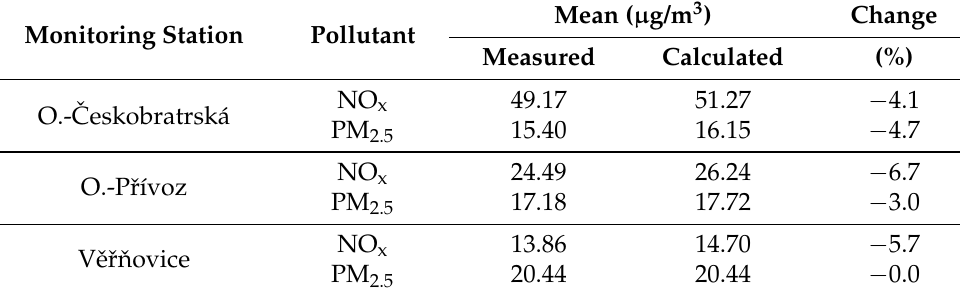
Table 5. Summary results of the mean value